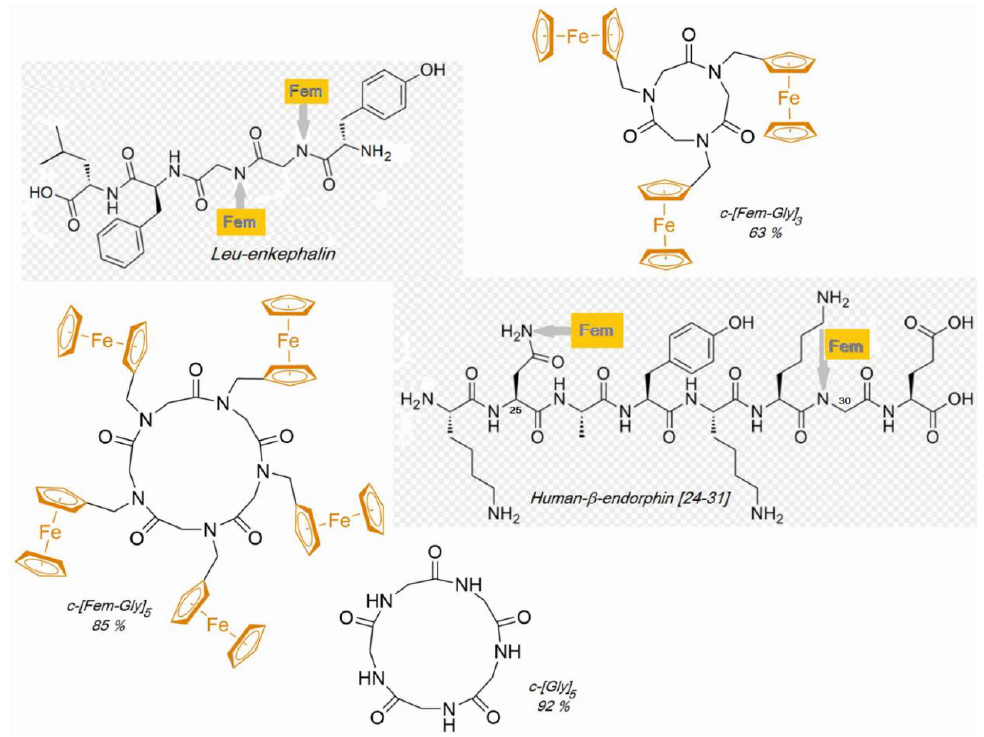
Figure 5. Synthesis of peptides otherwise hardly accessible, via their Fem-derivatives.